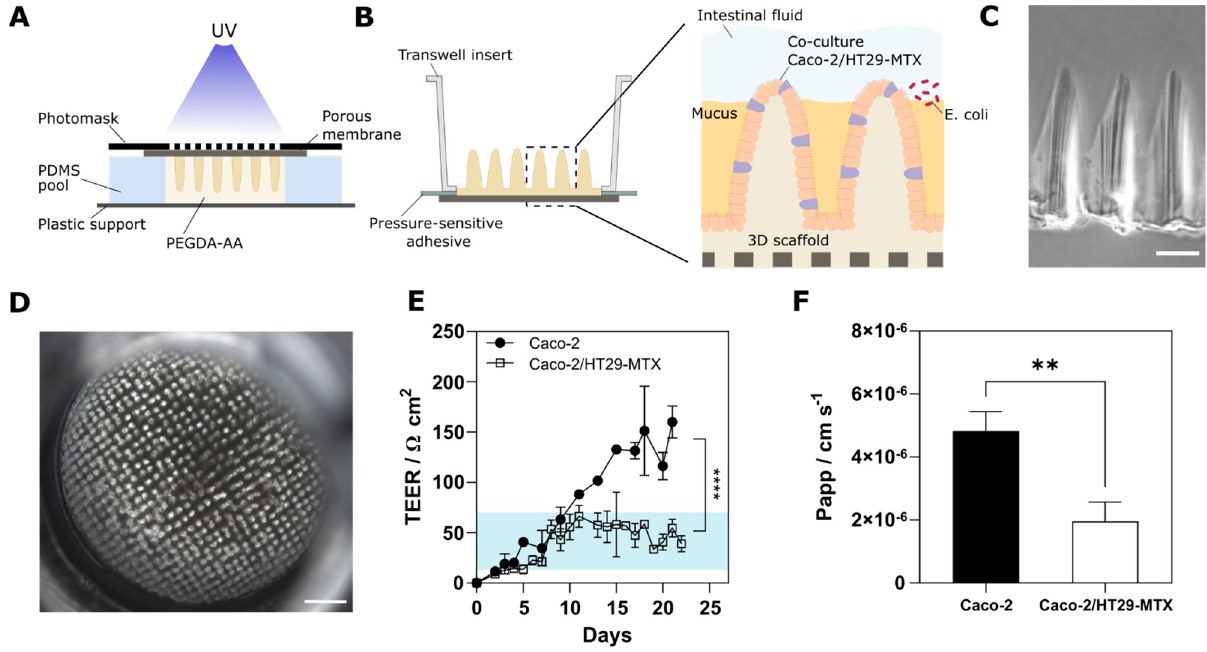
Figure 1. Fabrication of the 3D villus-like microstructured models. ( A ) Schematic drawing of the fabrication method of the villus-like hydrogel scaffold. ( B ) Schematic drawing of the villus-like hydrogel assembled into a conventional Transwell insert. The 3D biomimetic model of the small intestinal barrier contains the microstructured villus-like hydrogel scaffold; the epithelial cell barrier co-culturing the enterocyte-like Caco-2 cells and the goblet-like HT29-MTX cells; the secreted mucus layer where the host–pathogen interactions occur; and the intestinal fluid. ( C ) Brightfield microscope image of the cross-section of the villus-like hydrogel scaffold. Scale bar = 200 μ m. ( D ) Top view image of the Caco-2/HT29-MTX co-culture on the villus-like hydrogel scaffold assembled on the Transwell insert after 21 days culture. Scale bar = 1 mm. ( E ) Transepithelial electrical resistance (TEER) of the 3D models along the days of culture (black dots: monoculture of Caco-2 cells; open squares: co-culture Caco-2/HT29-MTX). The blue shadow indicates the range of the reported TEER values of the human small intestine [32]. ( F ) Apparent permeability ( Papp ) values of the FD4 model compound across the 3D models. Mean ± SEM, n > 10, ** p < 0.01; **** p < 0.0001.